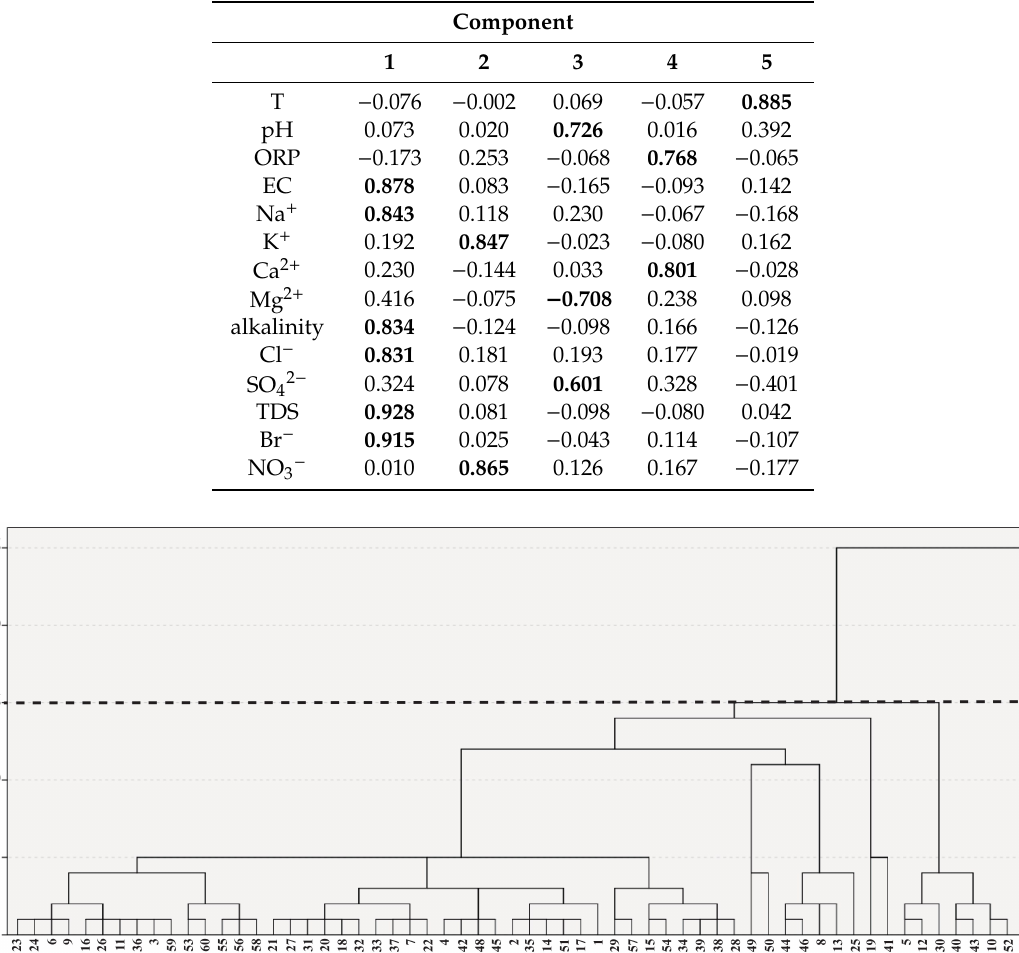
Table 4. Results of principal component analysis by Varimax with Kaiser Normalization [27]. Bold letter for R 2 > 0.5.